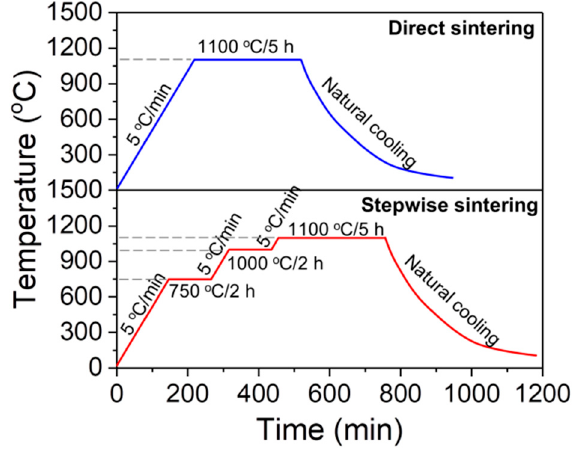
Figure 1. Two different sintering programs for solid-state synthesis of Sr 2 Fe 1.5 Mo 0.5 O 6 −δ perovskite.